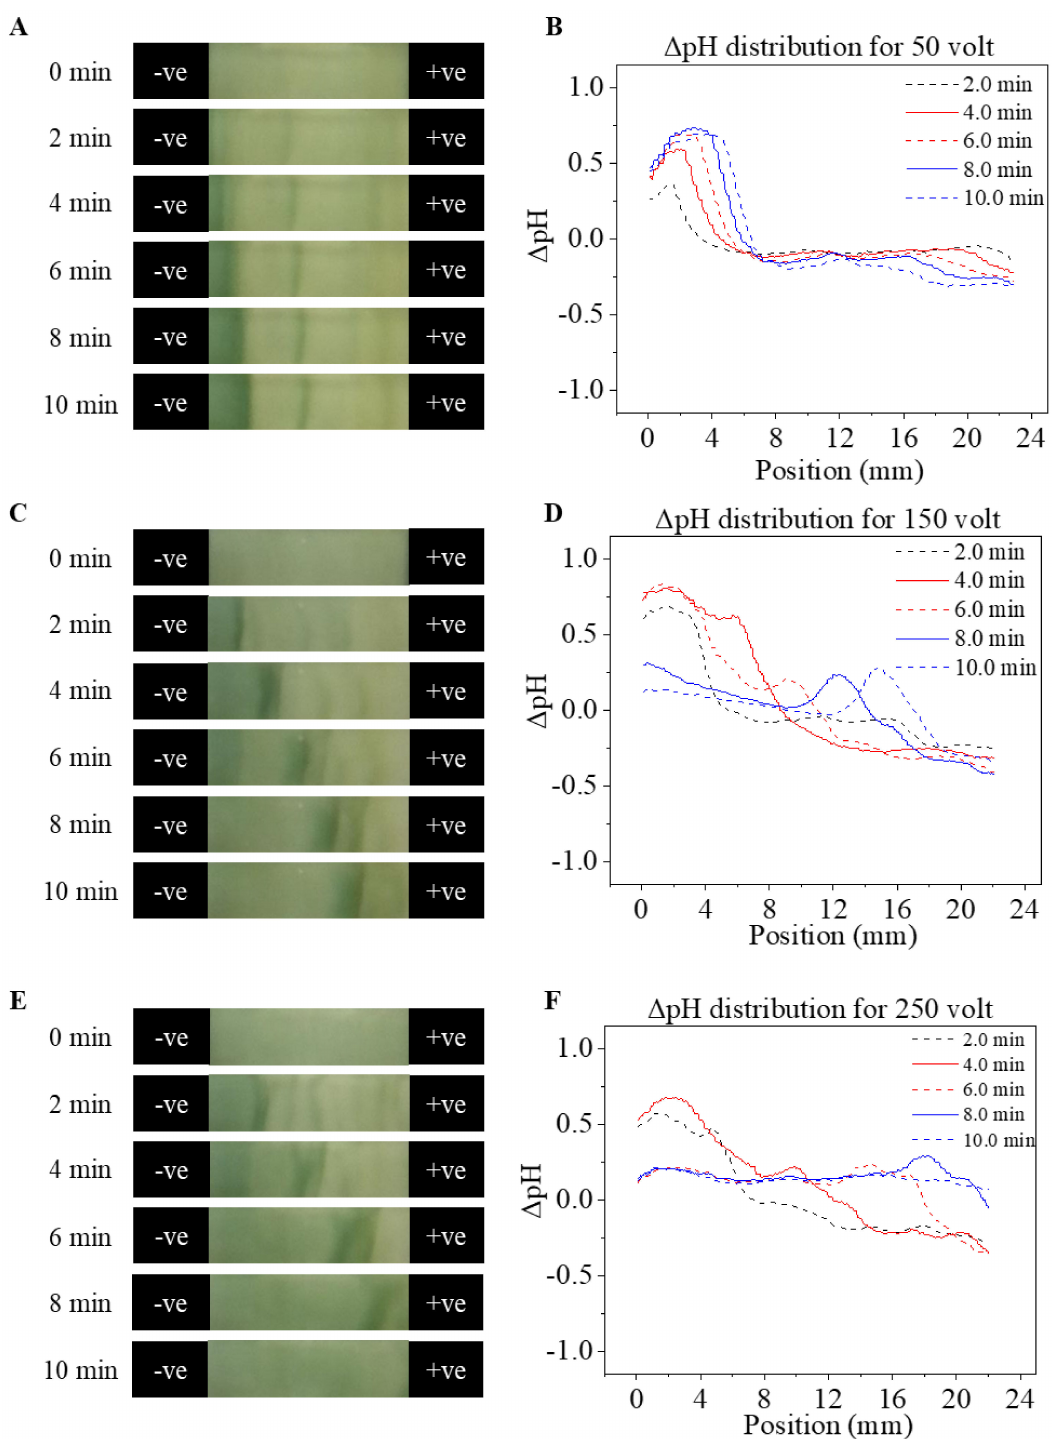
Figure 4. Spatial pH distribution at 0, 2, 4, 6, 8, and 10 min under different electric fields. ( A , B ) Time-lapse images and pH distribution on CA paper under 1667 V/m (50 V). ( C , D ) Time-lapse images and pH distribution on CA paper under 5000 V/m (150 V). ( E , F ) Time-lapse images and pH distribution on CA paper under 8333 V/m (250